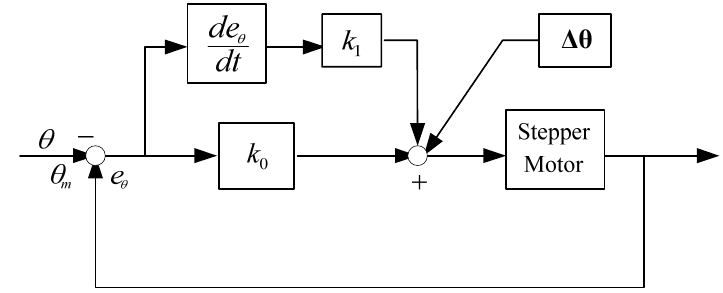
Figure 8. The scheme of the feed forward compensation-based PD